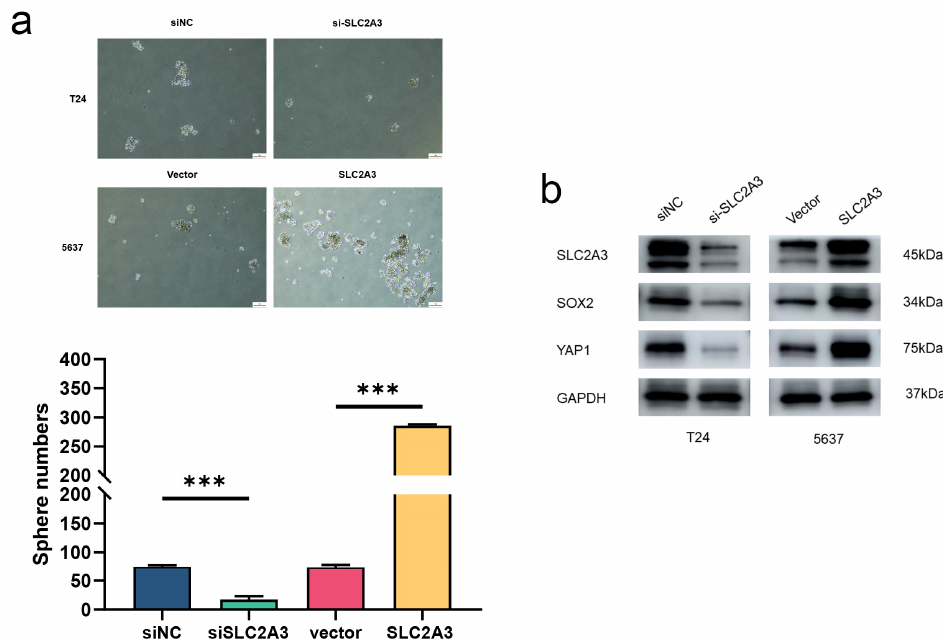
Figure 8. SLC2A3 overexpression promotes CSC traits, which can be suppressed by SLC2A3 inhibi- tion. ( a ) Representative images of tumor spheres of indicated SLC2A3 expression. ( b ) Western blot was performed with the indicated antibodies. *** p < 0.001.